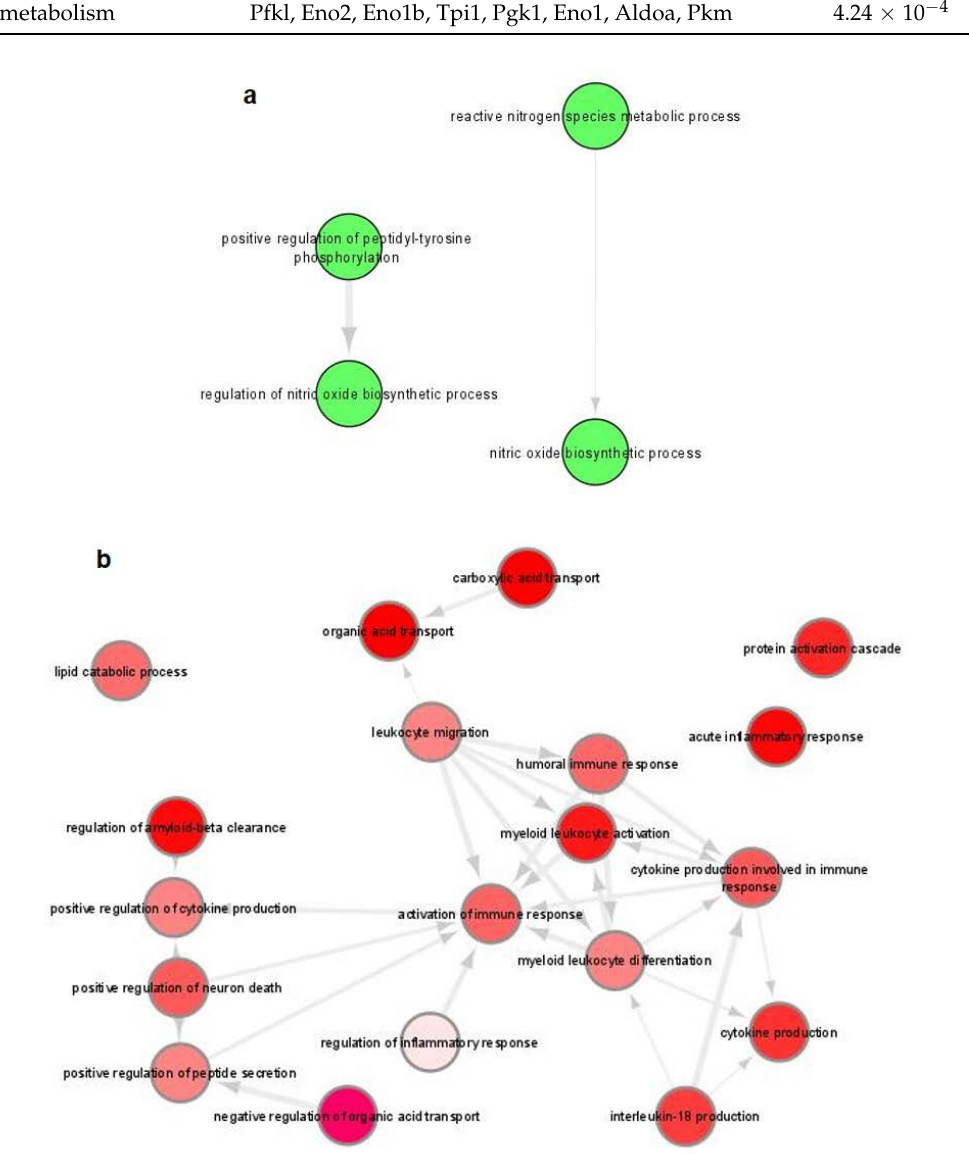
Figure 8. Gene ontology (GO) enrichment analysis of DEGs in fixed parasites-harboring